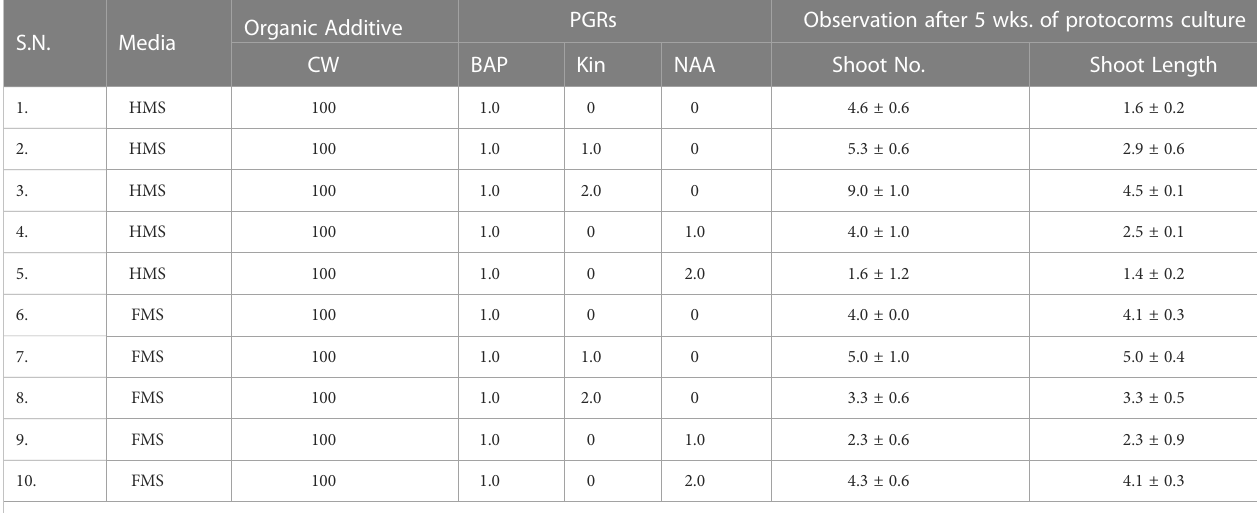
TABLE 2 In-vitro shoot development of D. transparens in various media supplements.